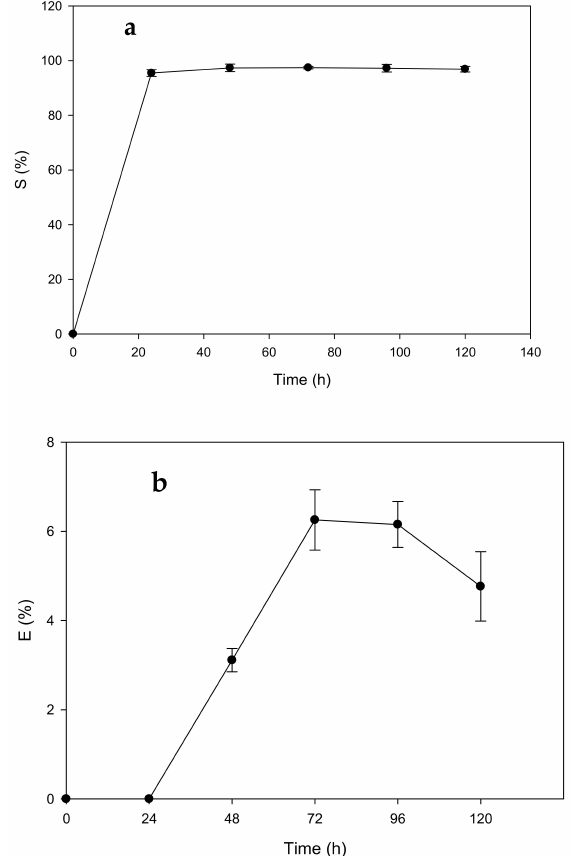
Figure A5. Time course of water swelling at 25 ◦ C and RH of 45% ( a ) and MCP erosion behavior in acidic solution (pH 4) ( b ).